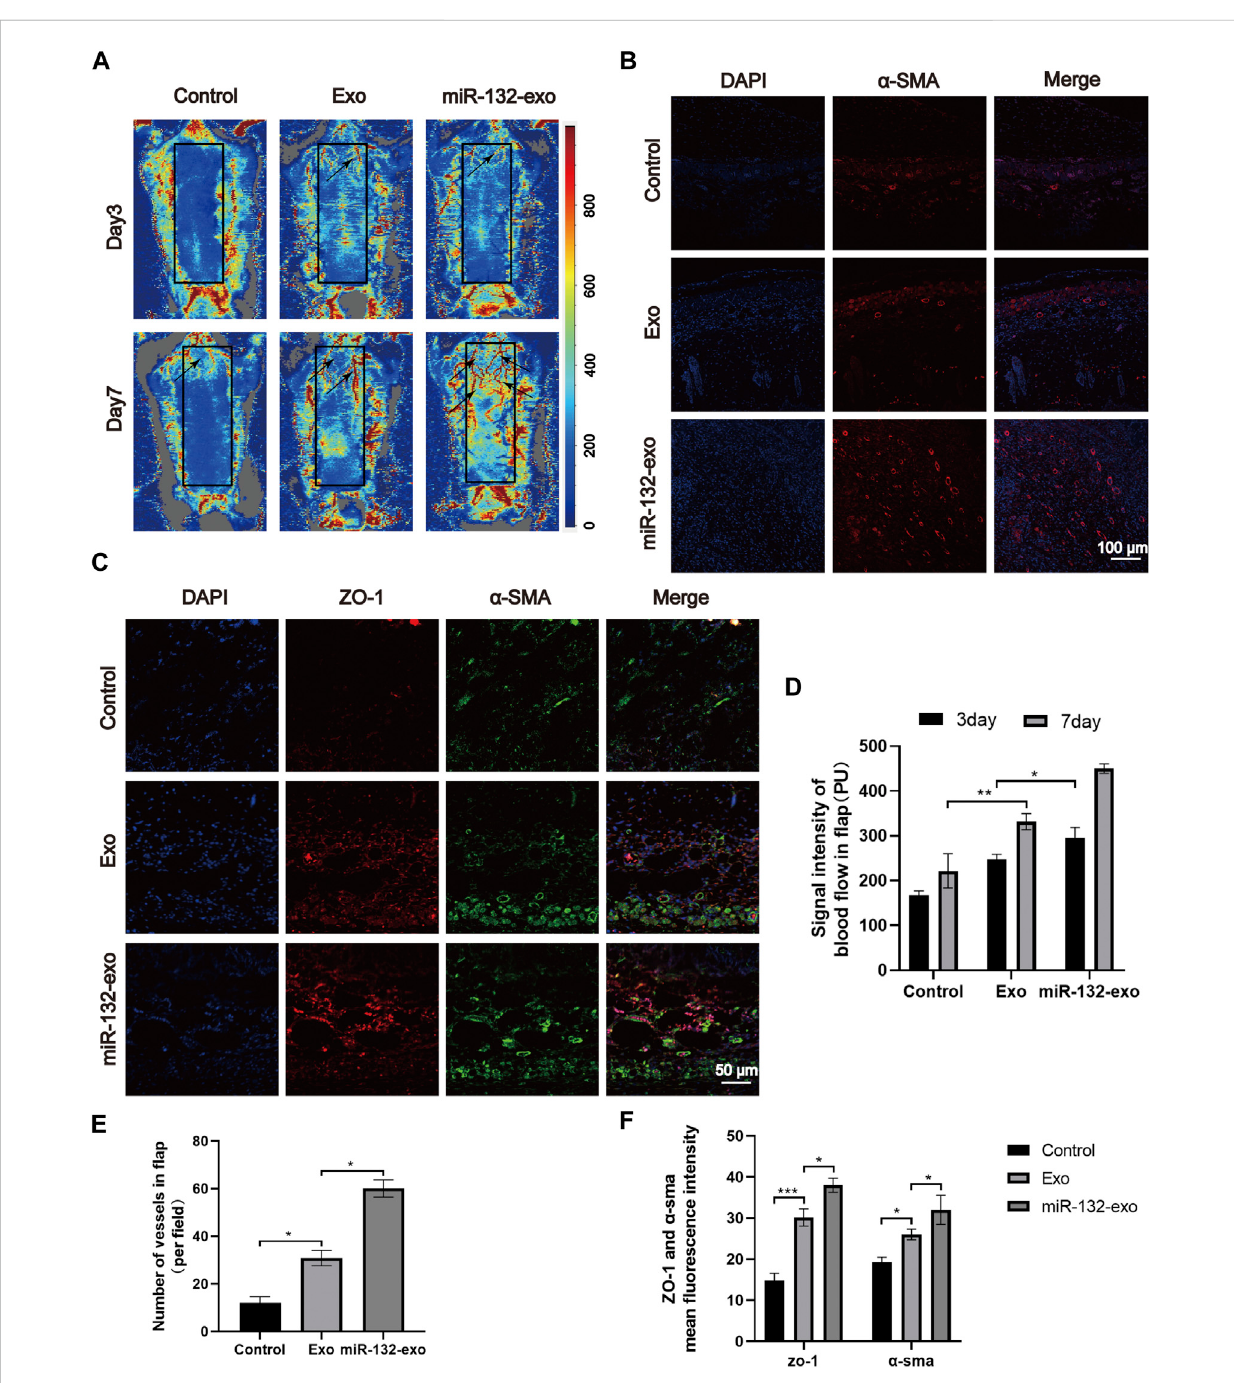
FIGURE 5 ThemiR-132-exopromotedangiogenesisandvascularnetworkformationindiabeticrandomskin fl aps. (A) RepresentativelaserDopplerimageson postsurgery day 3 and day 7; the arrows indicate the new blood vessels; (B) Representative immuno fl uorescence staining images of α -SMA-positive microvessels in each group on day 7, scale bar = 100 μ m; (C) Representative immuno fl uorescence staining images of ZO-1 (red) and α -SMA (green) co- staining in each group on day 7, scale bar = 50 μ m; (D) Quantitative data of signal intensity of blood fl ow in random skin fl aps in each group; (E) Quanti fi cation of newly formed vessels per fi eld corresponding to immunostaining of α -SMA; (F) Quanti fi cation of mean fl uorescence intensity per fi eld corresponding to co-staining of ZO-1 and α -SMA. * p < 0.05, ** p < 0.01, *** p < 0.001, data are presented as the mean ± SD, n =